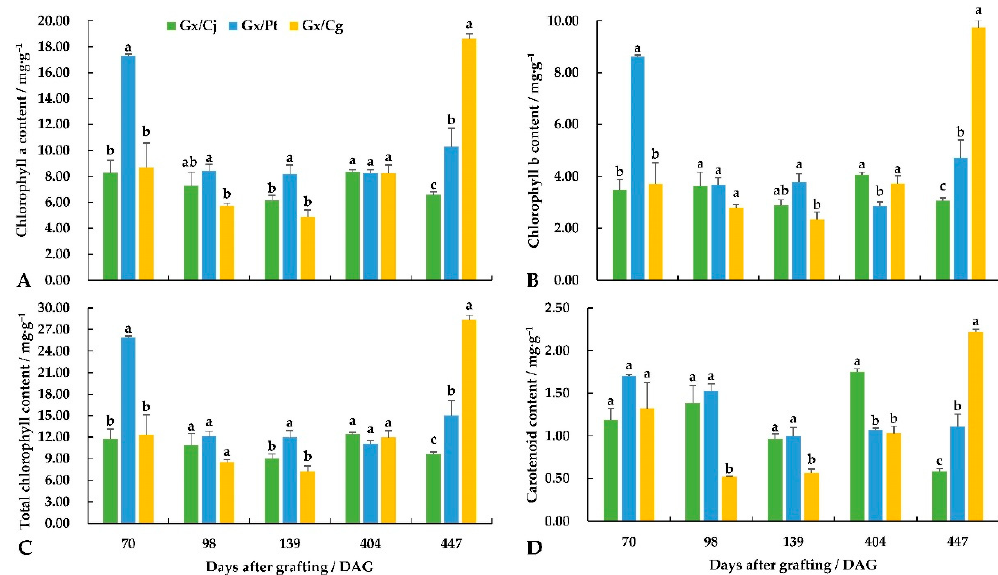
Figure 2. The changes in the chlorophyll and carotenoid content in the leaves among the different stages of ‘Guanxi Miyou’grafted onto three citrus rootstocks. ( A ) Chlorophyll a content. ( B ) Chloro- phyll b content. ( C ) Total chlorophyll content. ( D ) Carotenoid content. Different lowercase letters indicate a significant difference at the 0.05 level at the same sampling stage. The same as below.